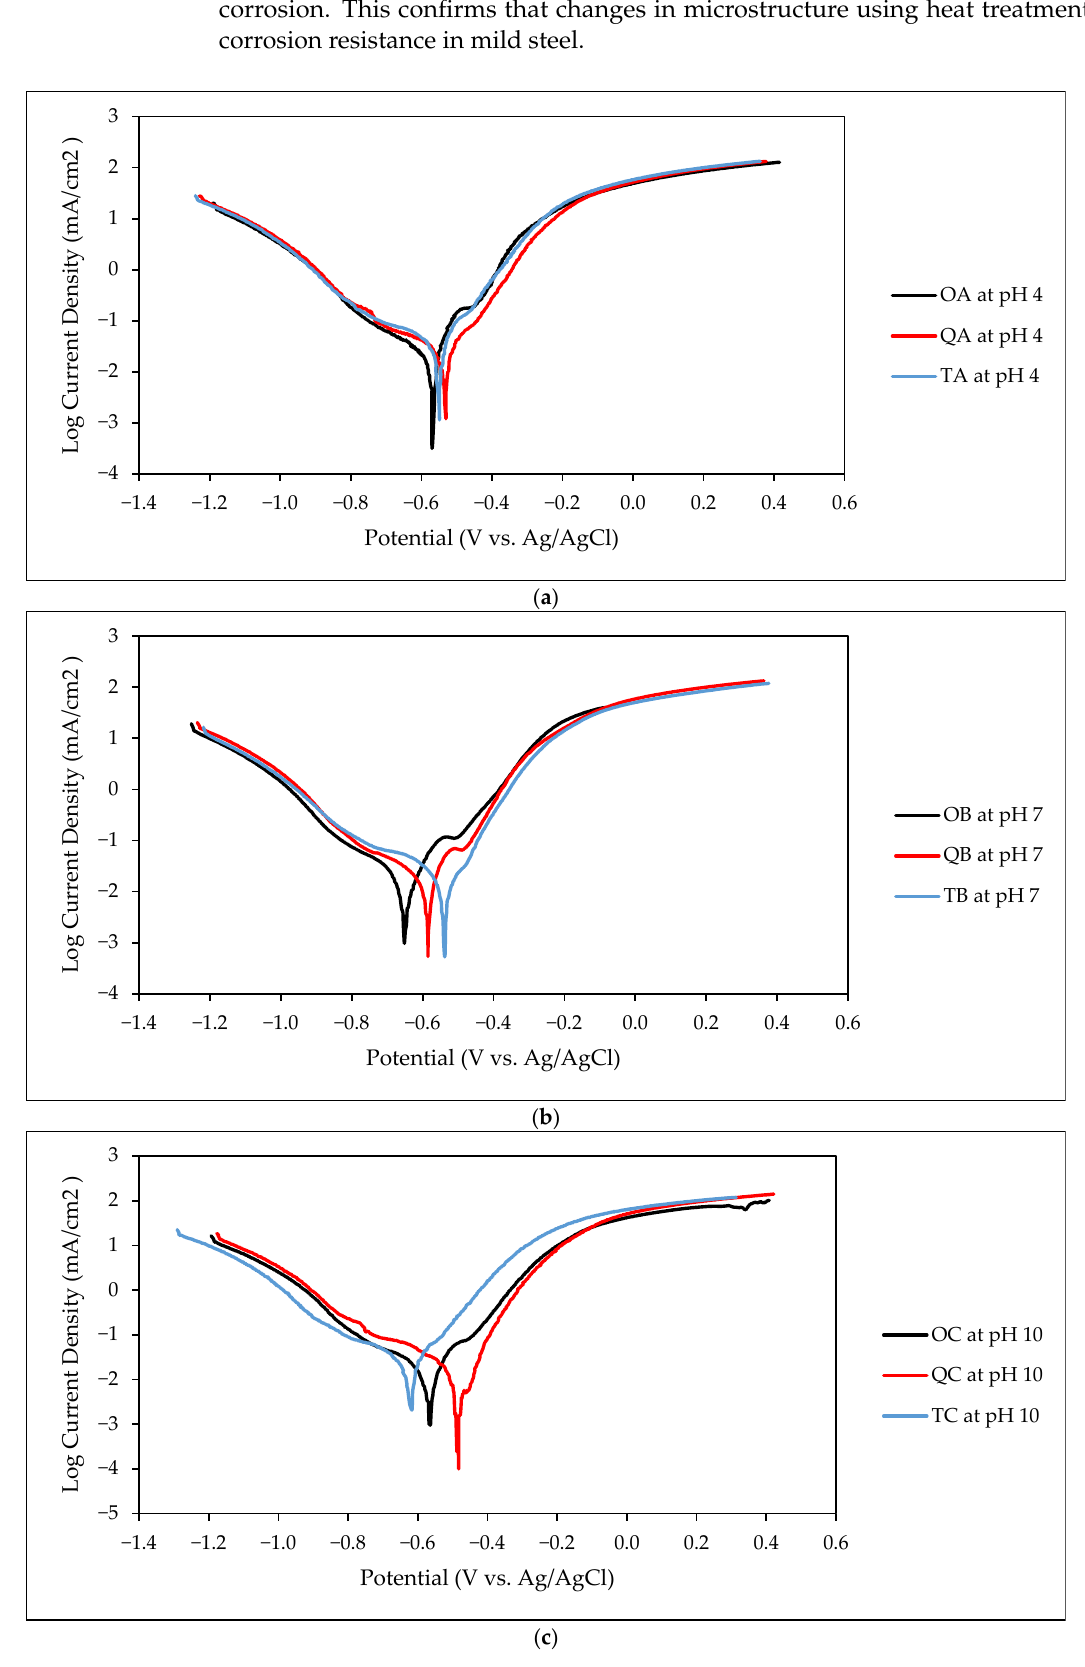
Figure 7. TAFEL curve of O, Q, and T samples at ( a ) pH 4, ( b ) pH 7, and ( c ) pH 10 in Cl −